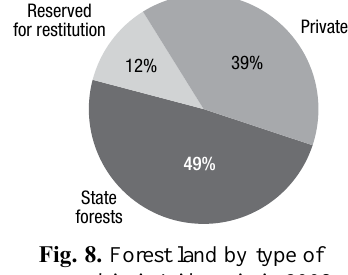
Fig. 8. Forest land by type of